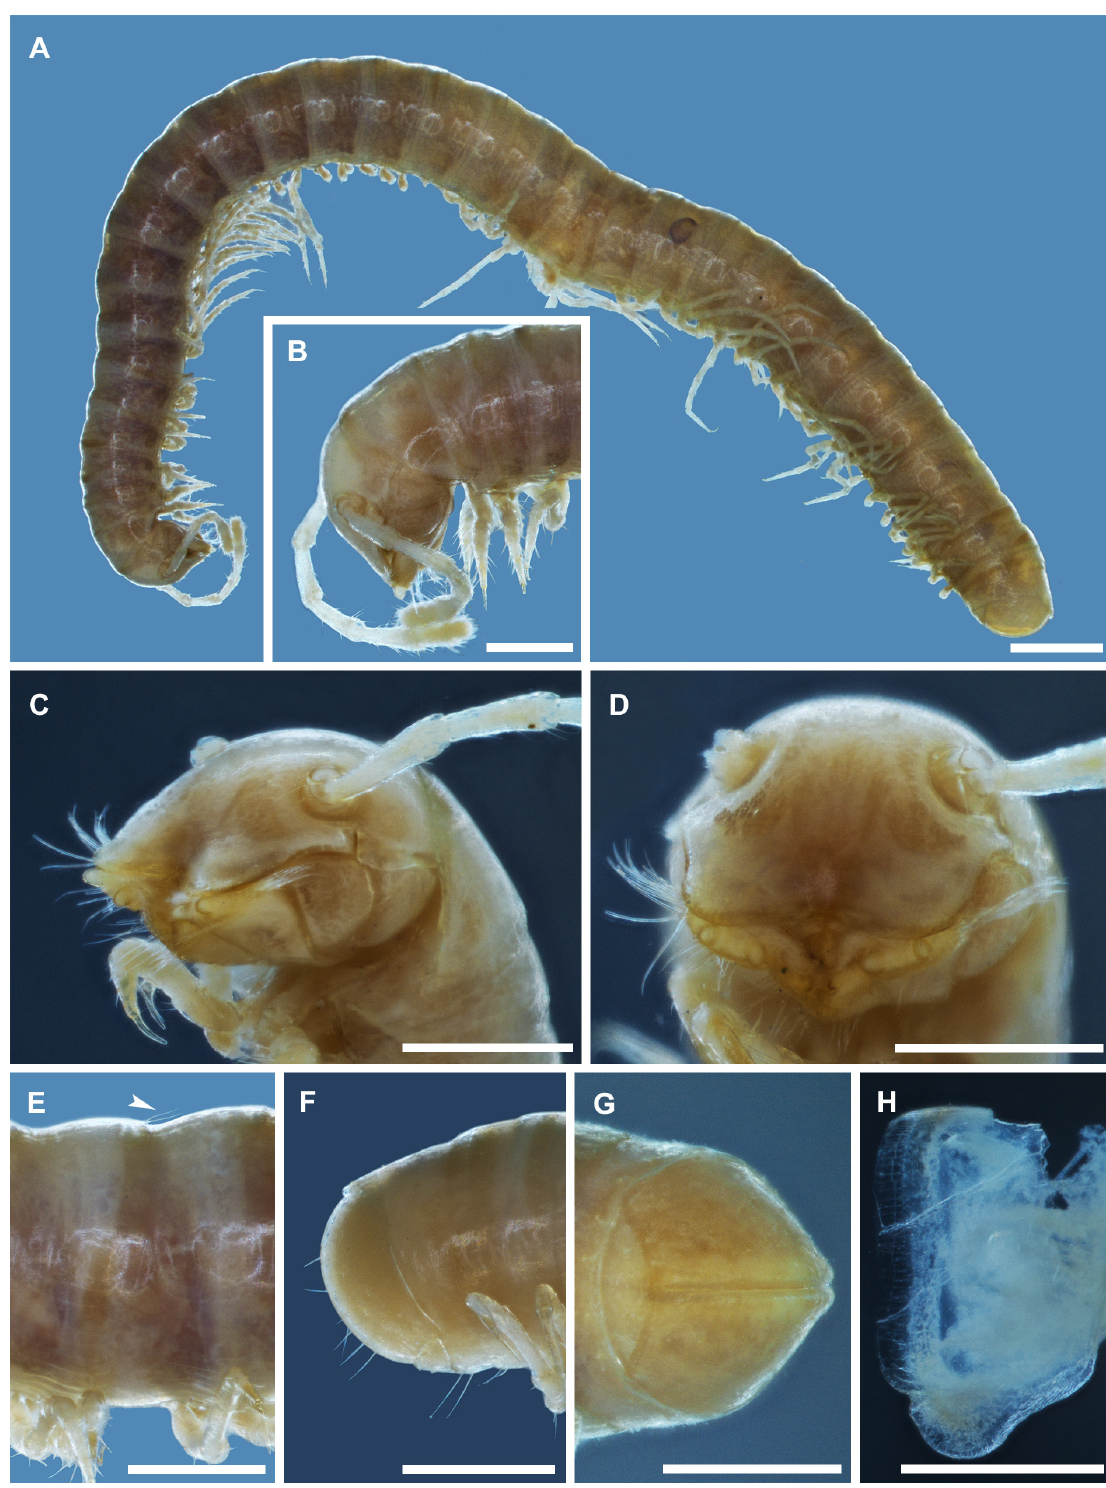
Fig. 39. Leucogeorgia mystax sp. nov., types from Nytshka Cave. A . Paratype ♀, habitus, lateral view (ZMUM). B . Paratype ♀♀, head, lateral view (ZMUM). C . Paratype ♀, head, anterolateral view (IZB). D . Paratype ♀, head, anterior view (IZB). E . Paratype ♀, midbody rings, lateral view (ZMUM). F . Holotype ♂, telson, lateral view (ZMUM). G . Paratype ♀, telson, ventral view (IZB). H . Holotype, body ring 7, lateral view. Scale bars: A = 1 mm; B–H = 0.5